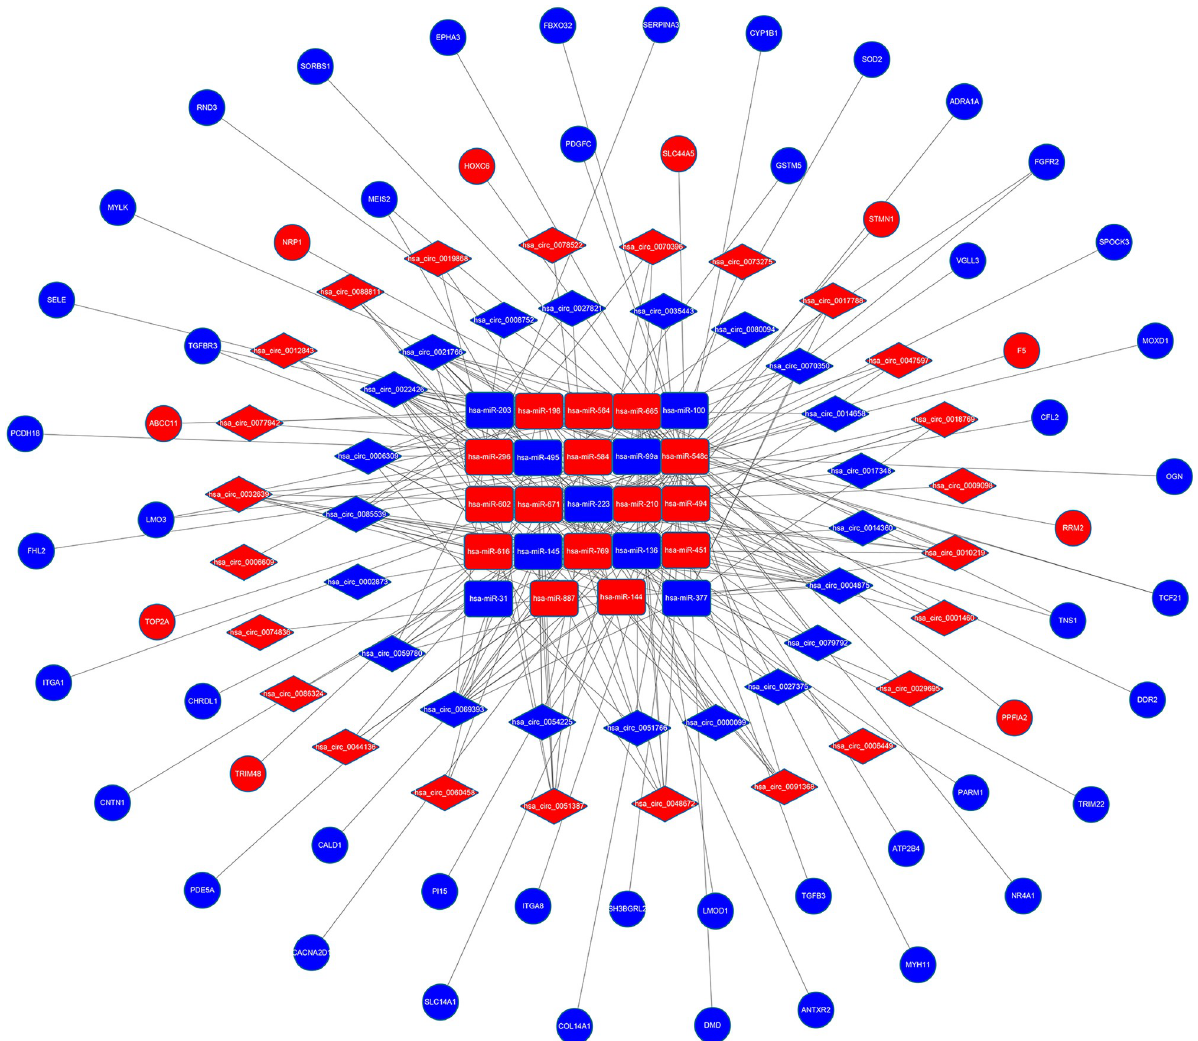
Fig 3. The circRNA-miRNA-mRNA ceRNA network in mPCa. The network comprises 45 circRNA nodes, 24miRNA nodes and 56mRNA nodes. The rectangles indicate miRNAs, the diamonds indicate circRNAs, and the ellipses indicate mRNAs. The red nodes represent increased expression, and the blue nodes represent decreased